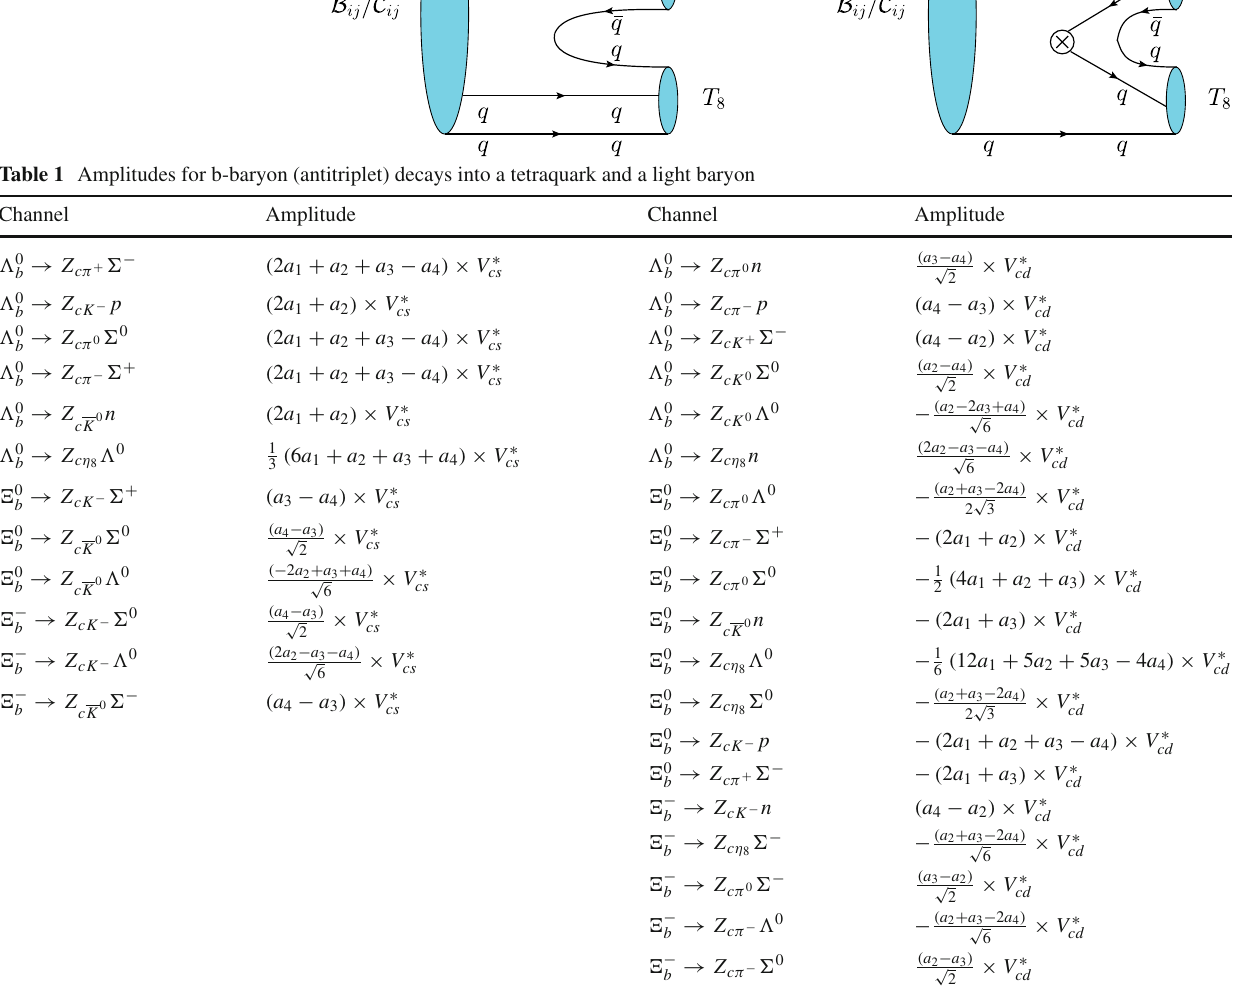
Fig. 2 Topological diagrams for a b-baryon decays into an octet tetraquark and a light baryon